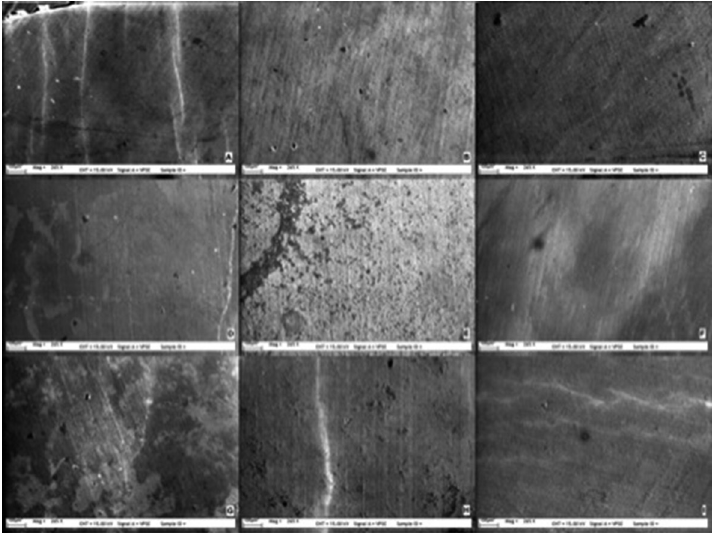
Table 4- Mean values and standard deviations of Ca, P and F (mass % contents) and Ca/P ratios